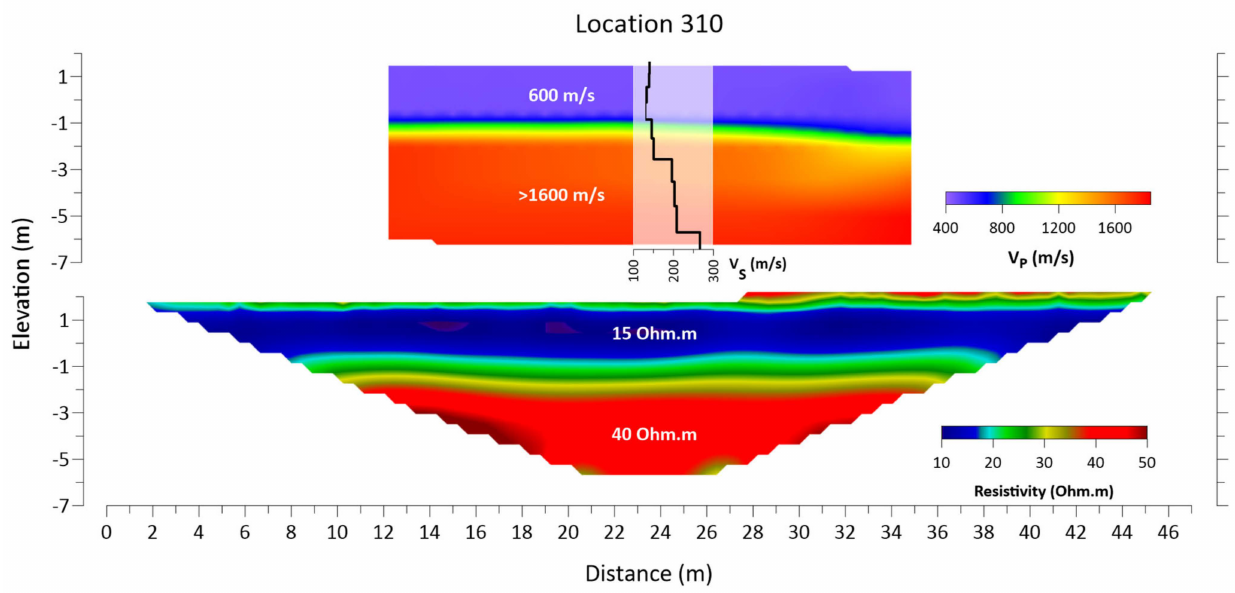
Figure 5. SRT and MASW ( top ) and ERT ( bottom ) sections at location 310, investigating the marl formation ( M m.st